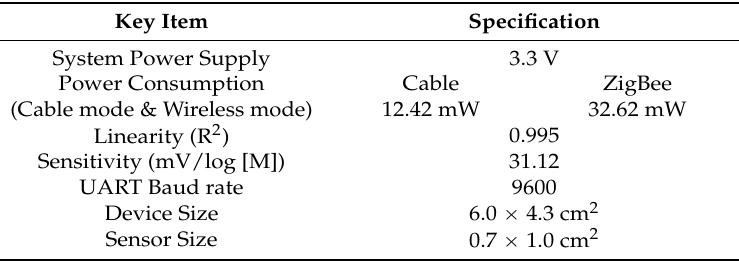
Table 4. Specifications results of the proposed system and